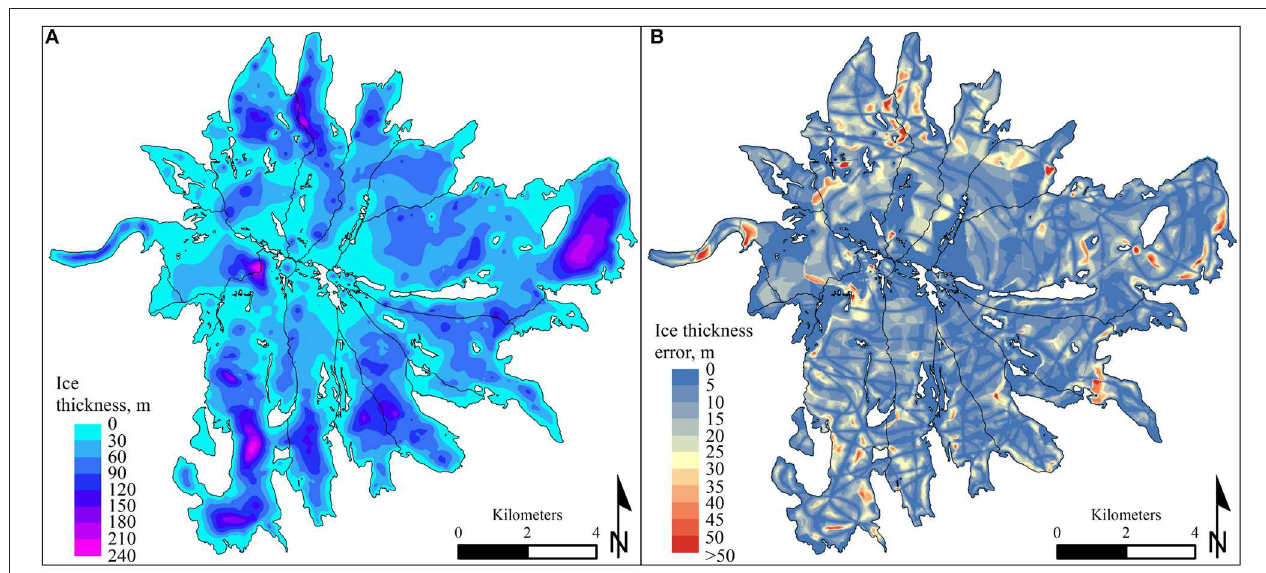
FIGURE 5 | (A) Ice thickness distribution of Elbrus glaciers and (B) predicted ice thickness